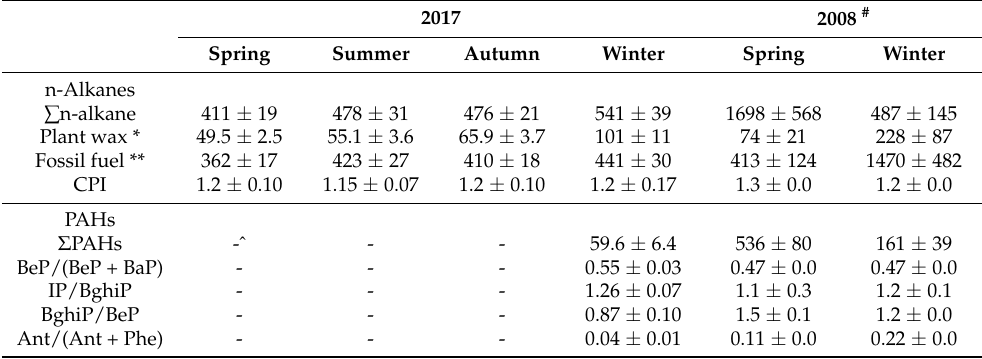
Table 3. Mass concentration of organic compounds and the diagnostic ratio of PAHs in Baoji in 2017 and 2008 (the confidence interval represents the standard deviation).